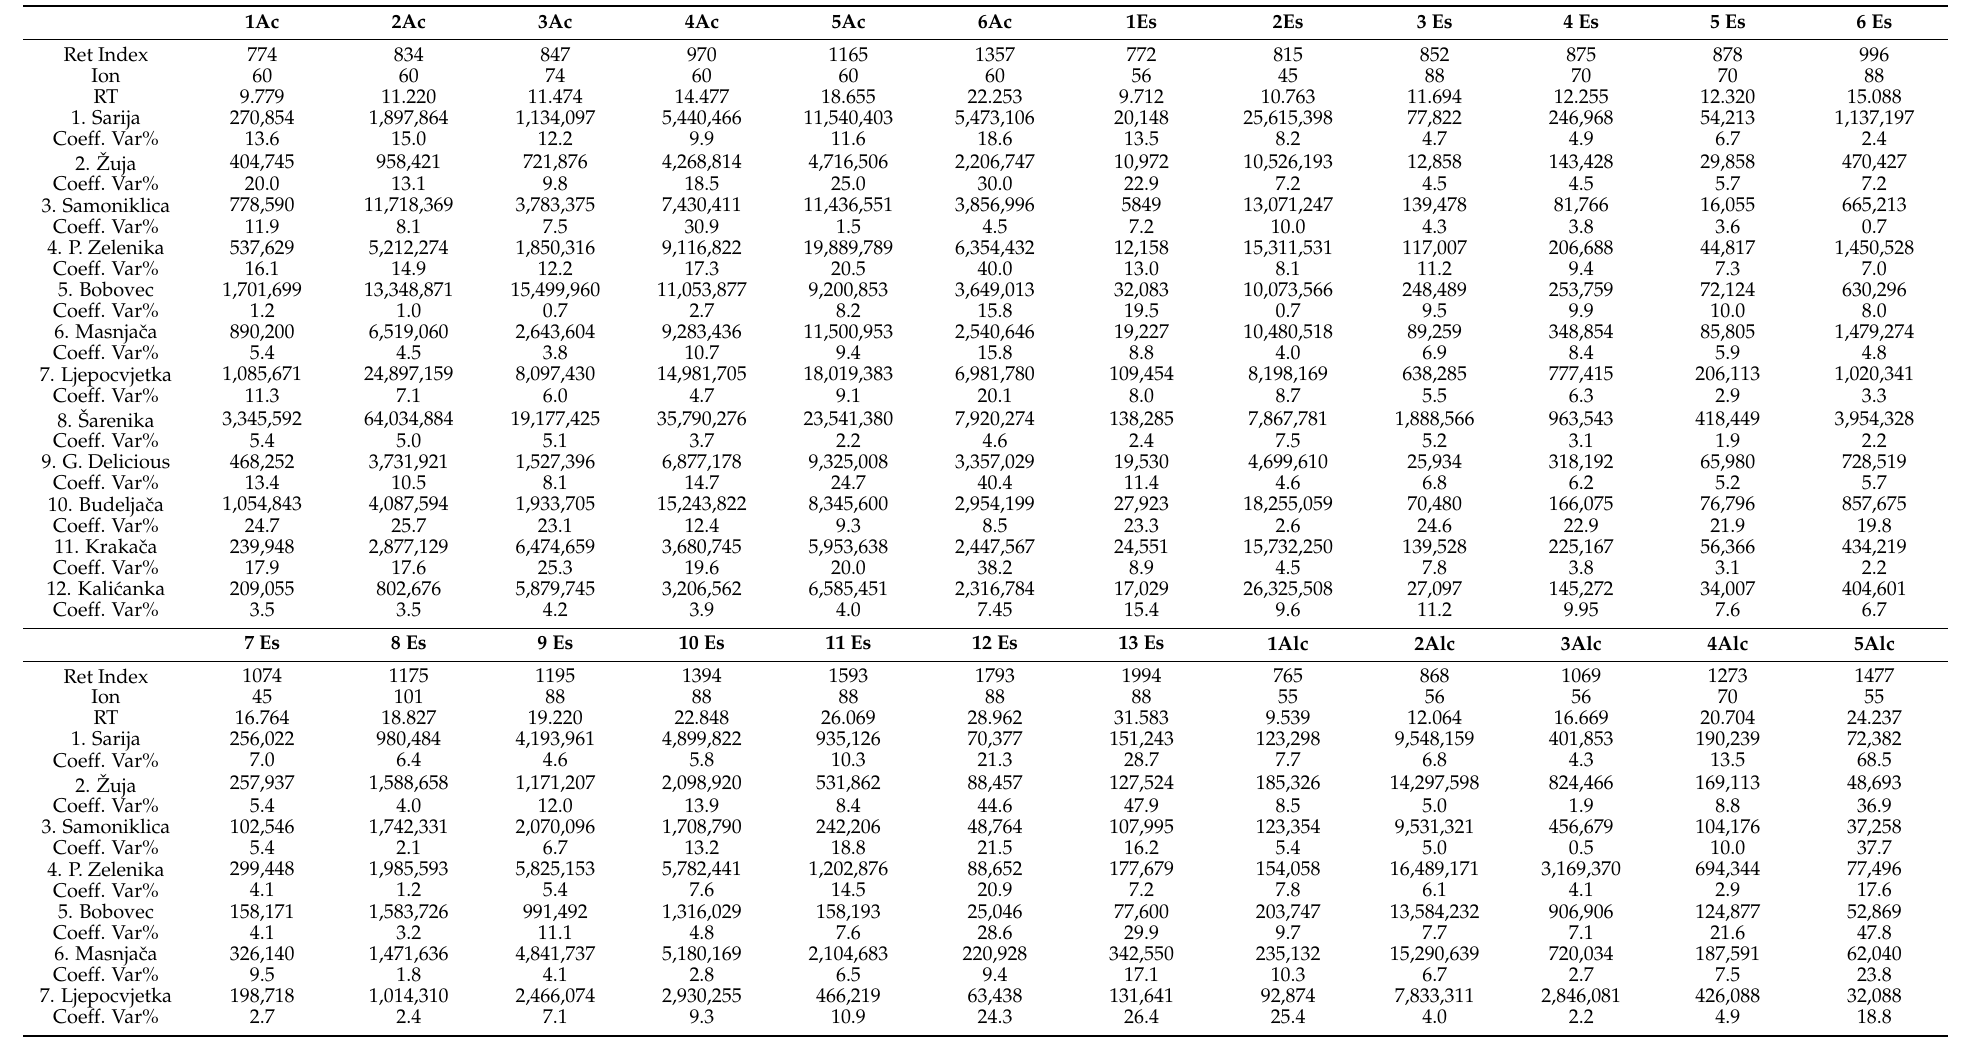
Table 2. Relative amounts of VOCs and coeffcient of variation (%) determined in spirit distilled from old apples (1–8), G. Delicious (9), and old pears (10–12), expressed as average peak areas obtained by HS-SPME-GC-MS ( n =